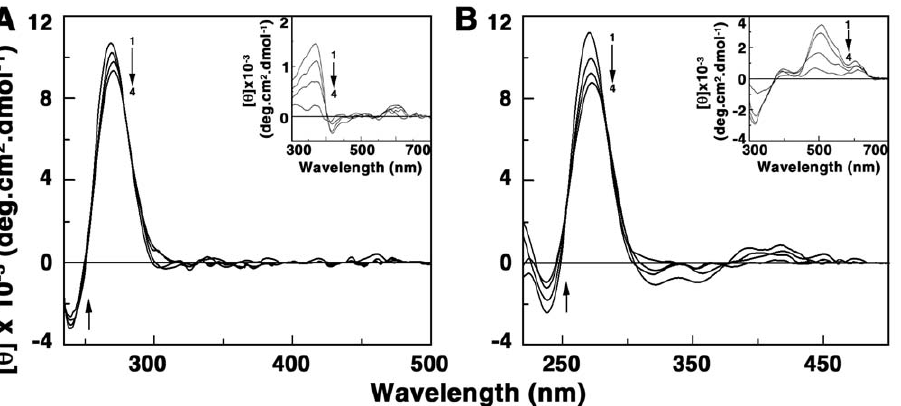
Figure 6. Circular dichroic spectra of tRNA-drug complexes. tRNA (60 m M) treated with (A) 30, 60, 90 and 108 m M (curves 1–4) of ADG and (B) 18, 36, 60 and 90 m M of DAU. Inset: Induced circular dichroic spectra of ADG and DAU,